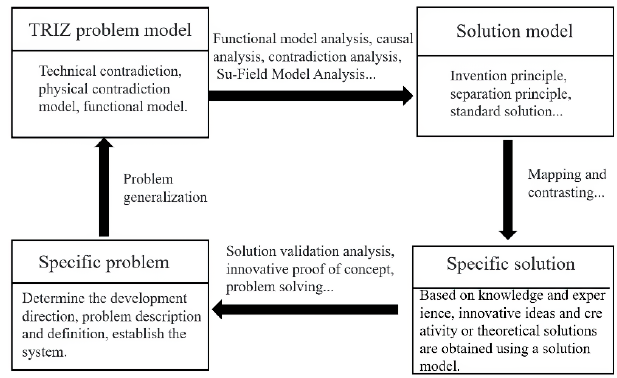
Figure 1. Flow chart of a TRIZ solution.